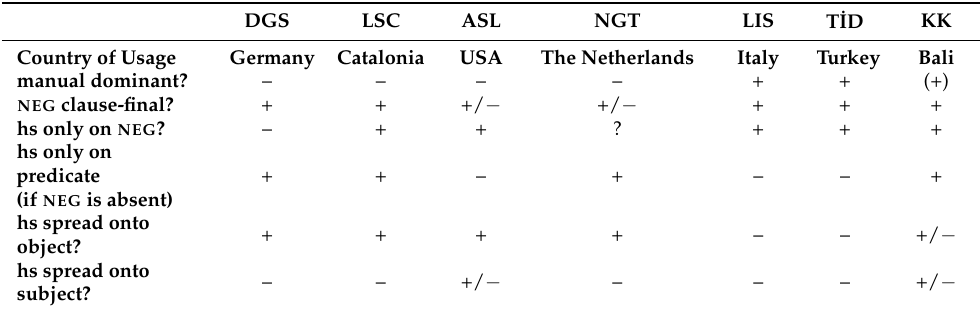
Table 3. Typological comparison of negation patterns across seven sign languages (adapted from Oomen and Pfau 2017; Kata Kolok